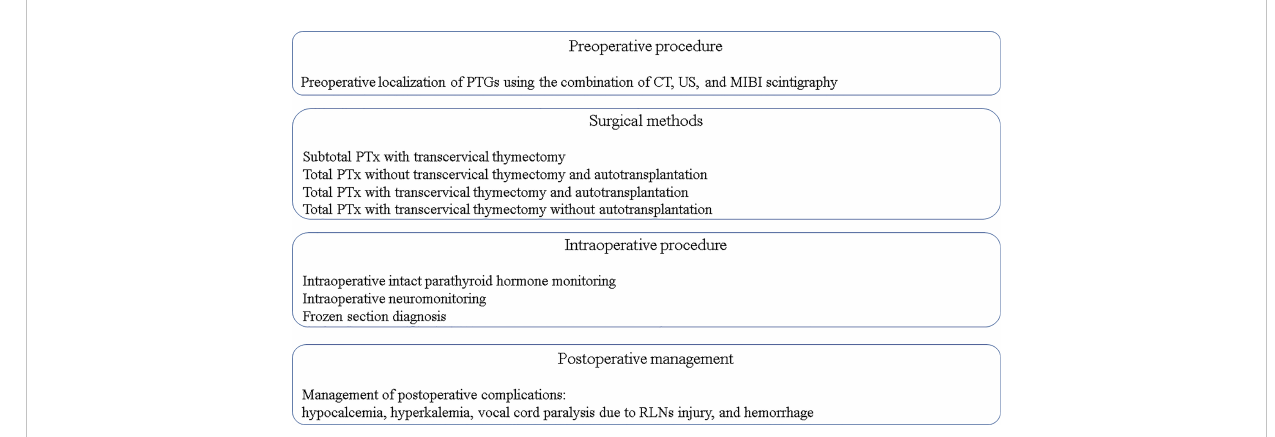
FIGURE 2 Key principles to achieve a successful PTx. CT, computed tomography; MIBI scintigraphy, 99m Tc-Sestamibi scintigraphy; PTx, parathyroidectomy; PTGs, parathyroid glands; RLNs, recurrent laryngeal nerves; US,